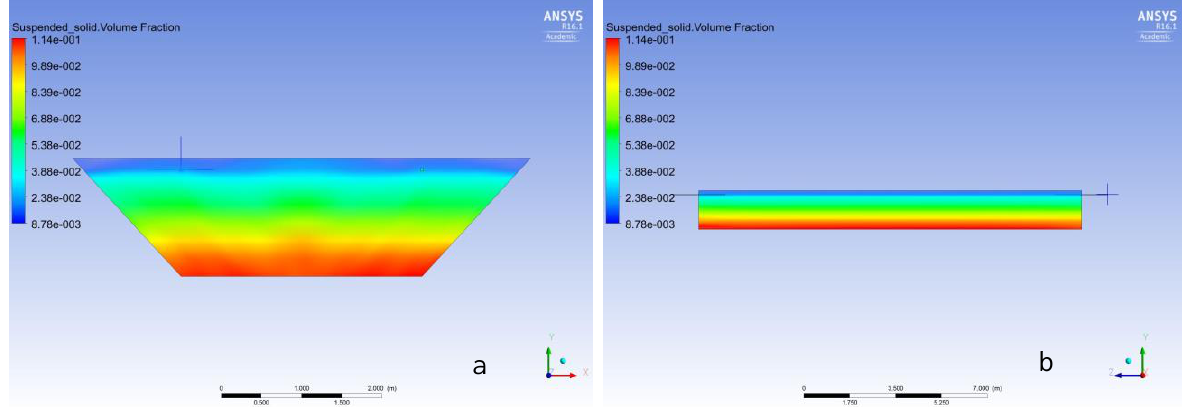
a b Figure 4. Distribution of the solids concentration in the FL: ( a ) inlet side depth wise profile ( b ) lengthwise centerline profile.